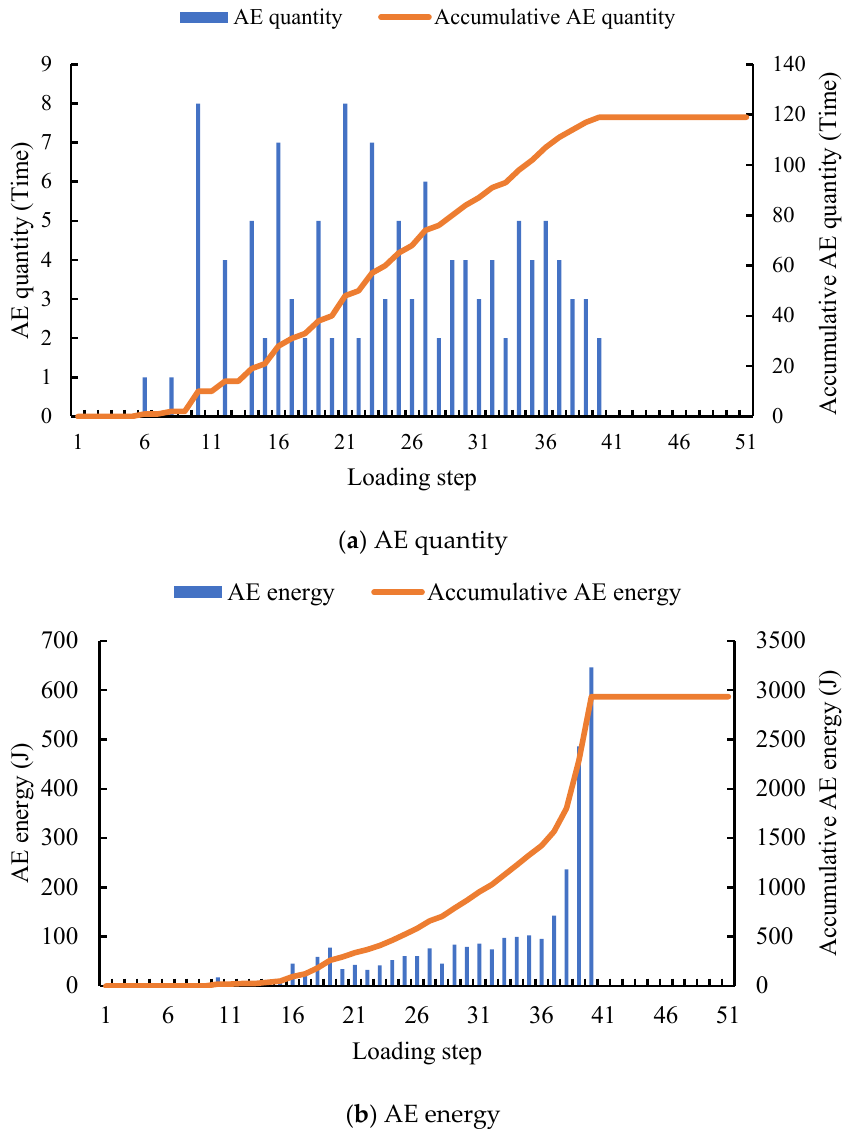
Figure 26. Variation trend of acoustic emission of specimen with geotextile interface.